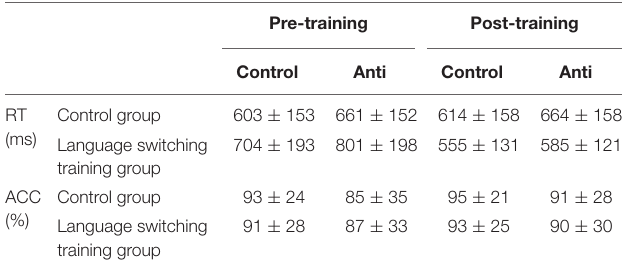
TABLE 5 | Model parameters for the best-fitting linear mixed effects model of the anti-saccade task in Experiment 1. Model